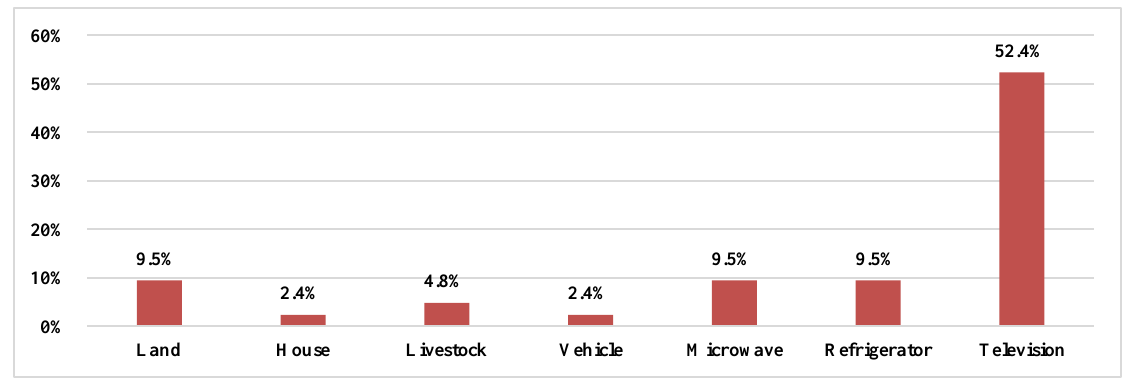
Figure 2: Asset ownership by the Youths; Source: Field Data